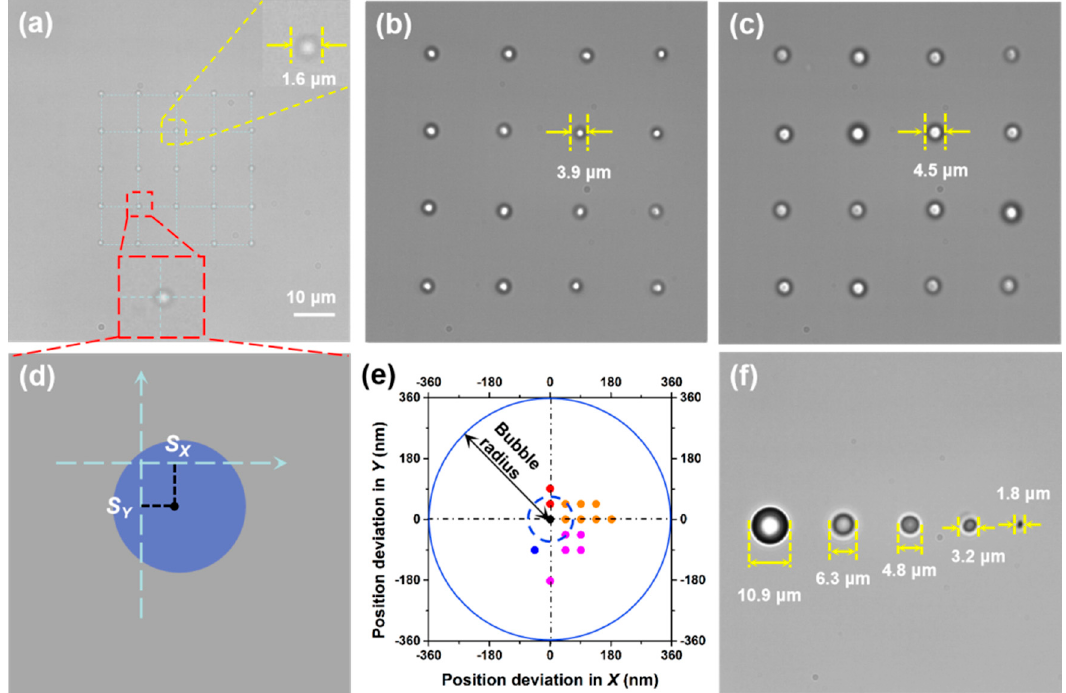
Figure 3. Formation of microbubble arrays. ( a ) A 5 × 5 array of microbubbles with an average diameter of 1.64 μ m. ( b ) A 4 × 4 array of microbubbles with an average diameter of 3.88 μ m. ( c ) A 4 × 4 array of microbubbles with an average diameter of 4.52 μ m. ( d ) Illustration of the position deviation in X ( S X ) and Y ( S Y ) directions for an individual microbubble. ( e ) Position deviations in X and Y directions for the microbubbles in the 2D array; ( a ) the dashed blue circle indicates the average deviation of ~90 nm from the target positions. ( f ) A row of microbubbles of different sizes ( n = 3).